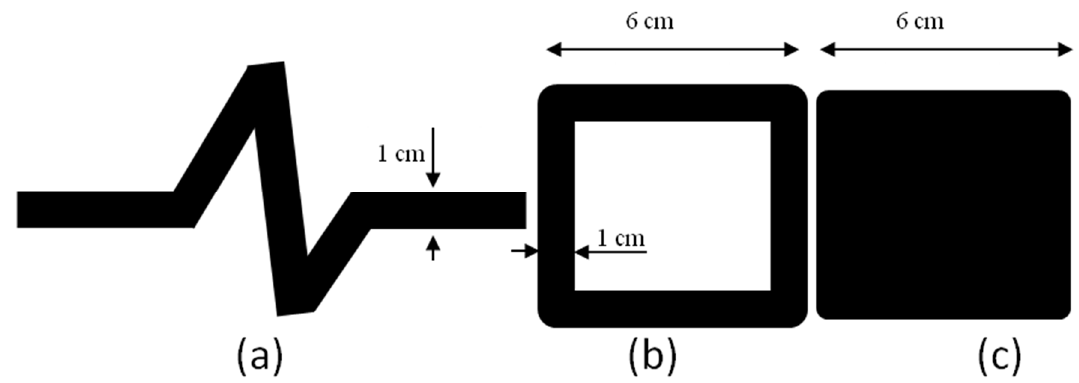
Figure 1. Patterns of printouts: ( a ) curve, ( b ) frame, ( c ) full square.